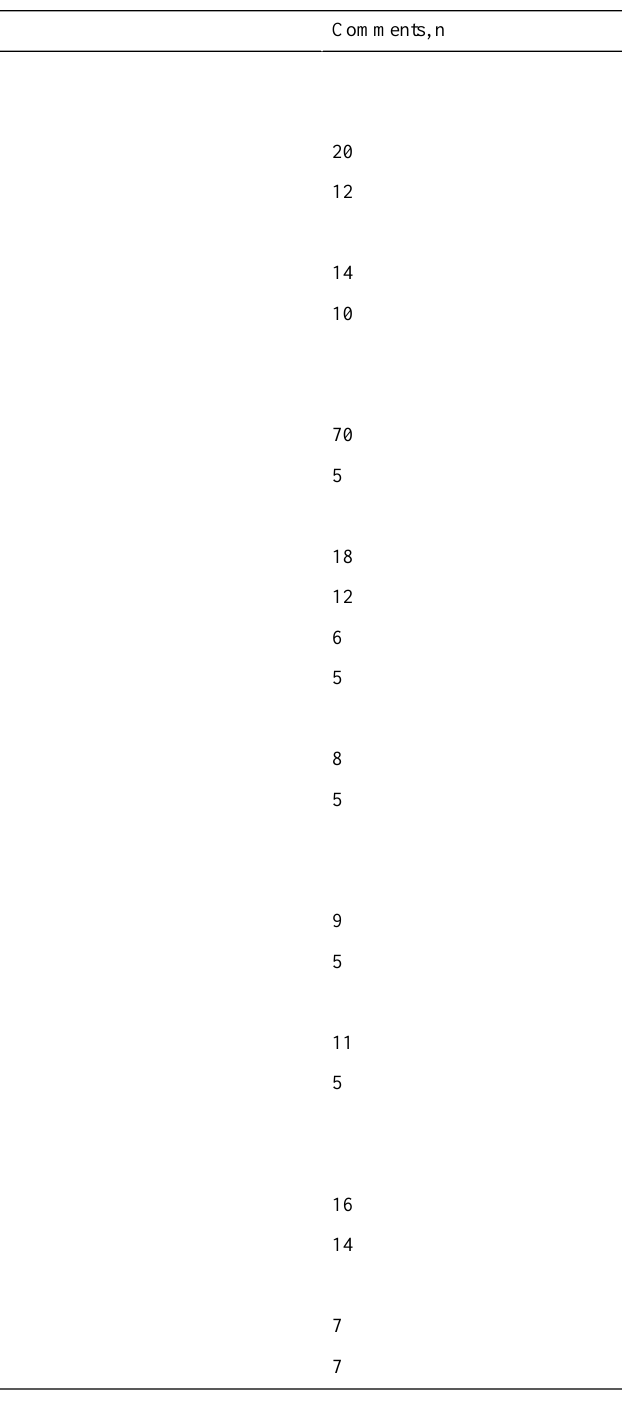
Comments, nThemes, subthemes, and codes or